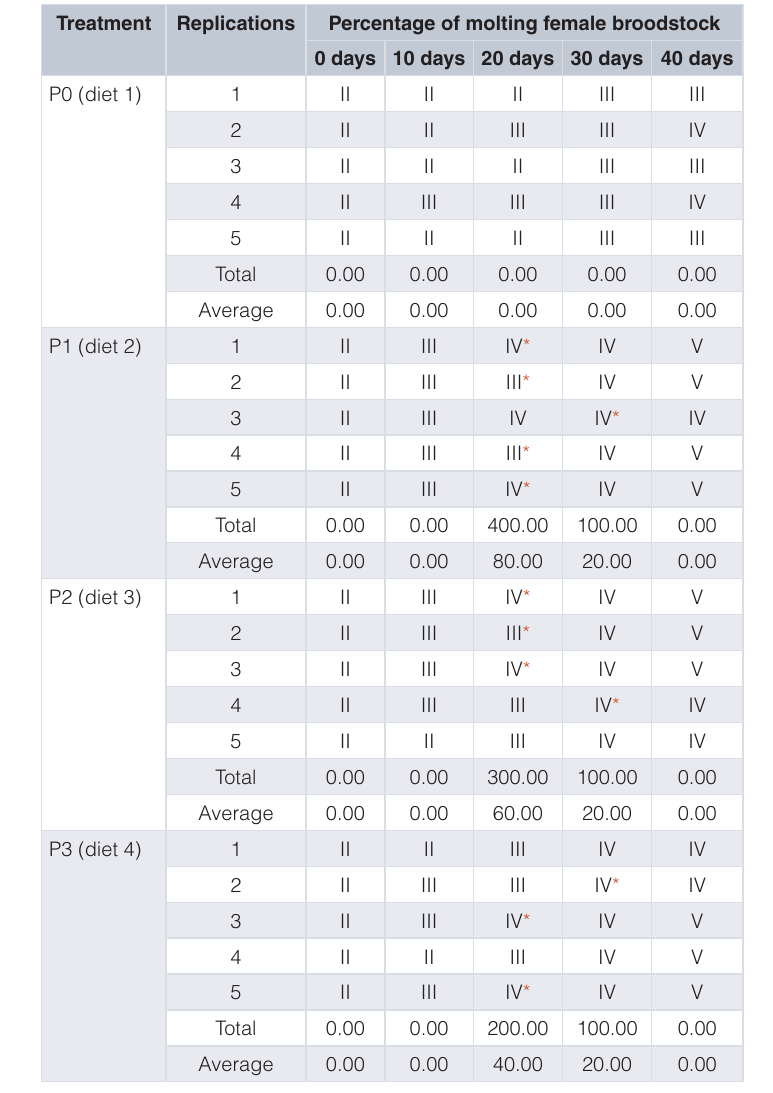
Table 1. Percentage of female broodstock blue swimming crabs, P. pelagicus (Linnaeus, 1758), that molted with a formulated diet of vitamin E supplementation at different